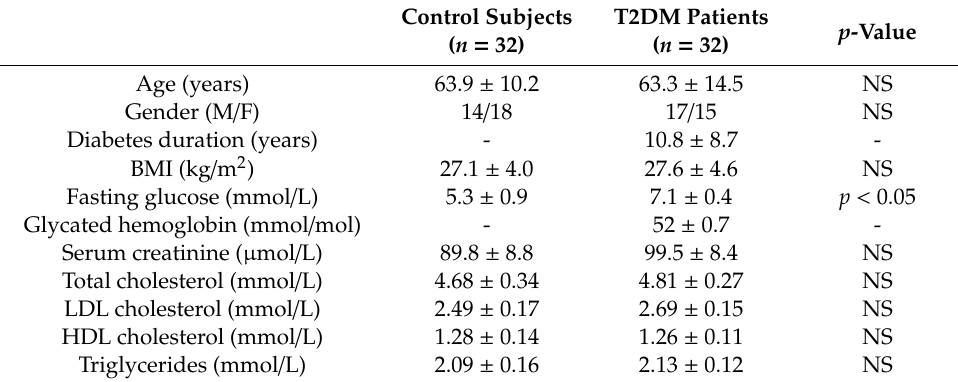
Table 2. Clinical and demographic characteristics of enrolled subjects.